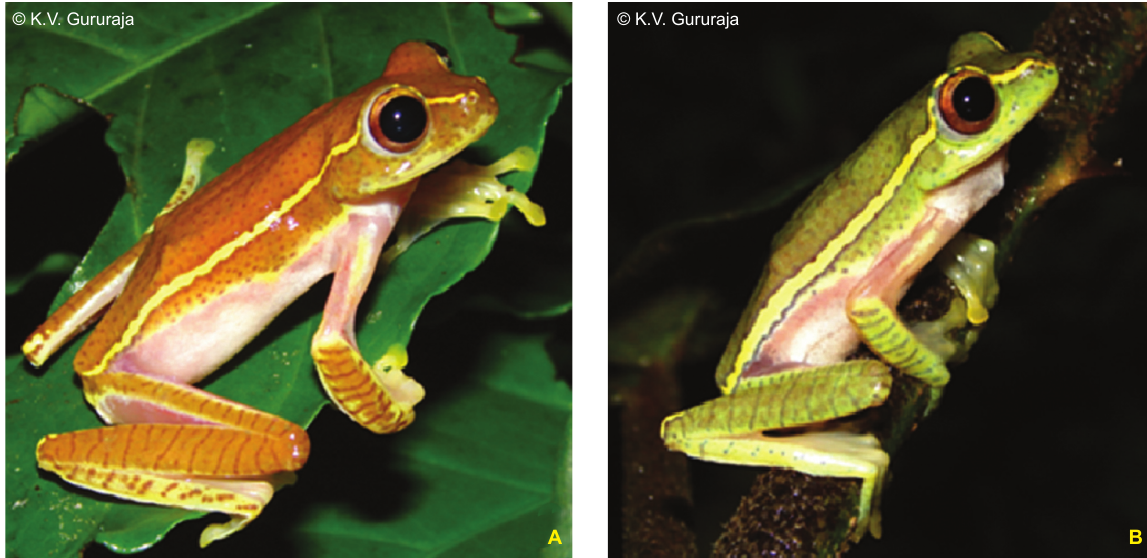
Image 1. Rhacophorus lateralis . A - with brown dorsum; B - with green